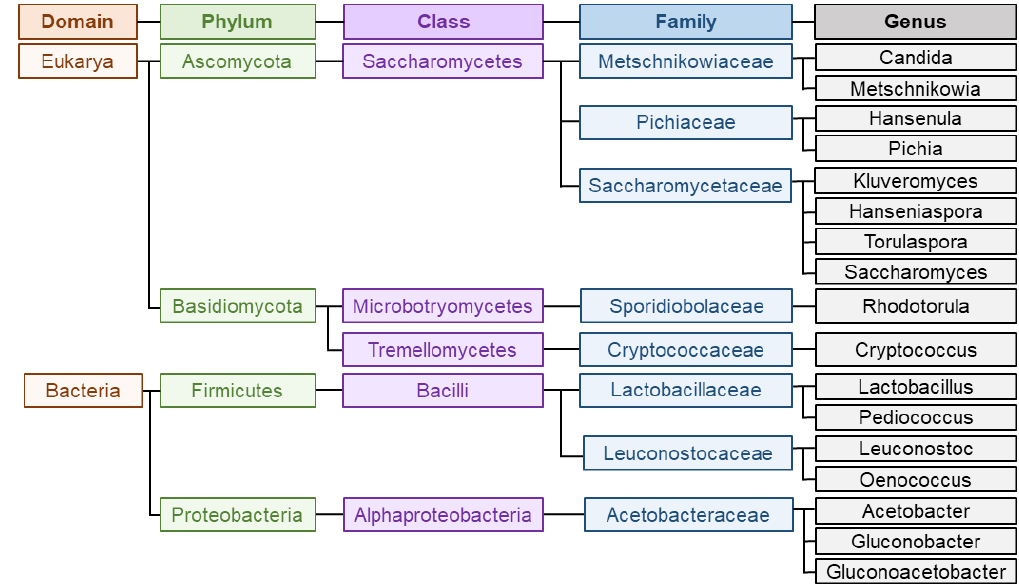
Figure 2. Main groups and taxonomy of the microorganisms implied in wine aroma production. Information extracted from Reference [30].